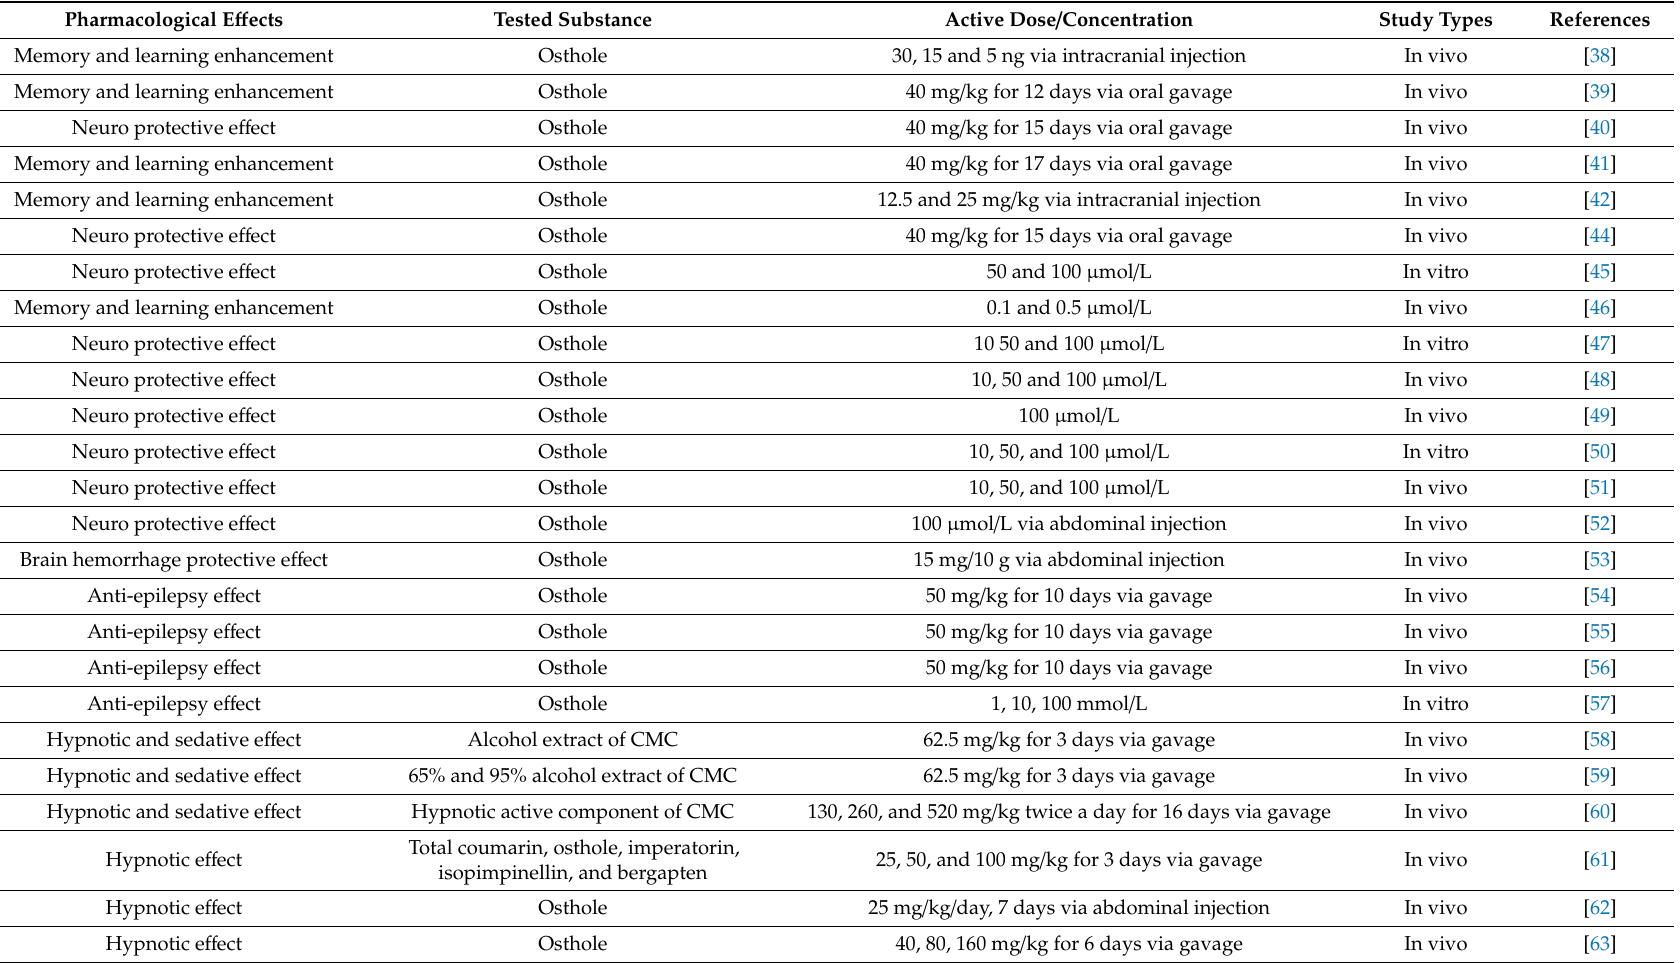
Table A1. Pharmacological e ff ects and activities of Cnidium monnieri (L.)